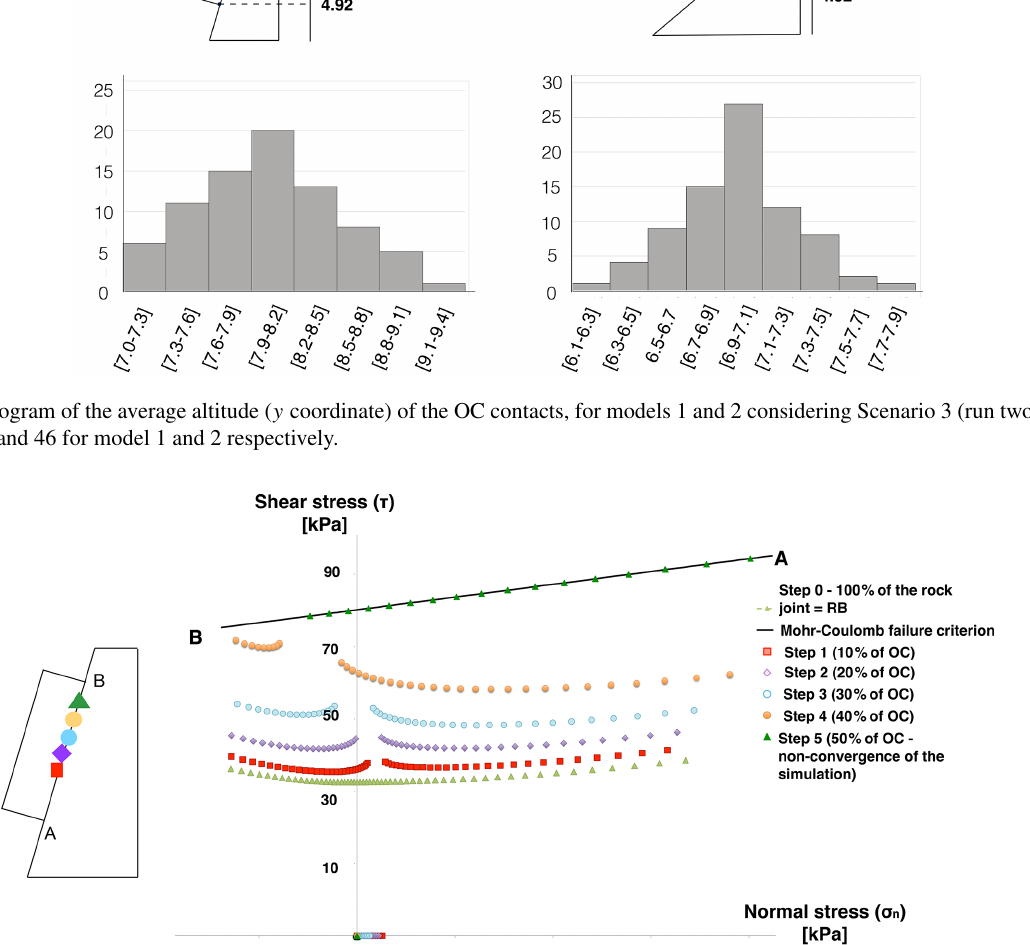
This model is based on model 1 (dip angle of 80 ◦ ), to which it will be